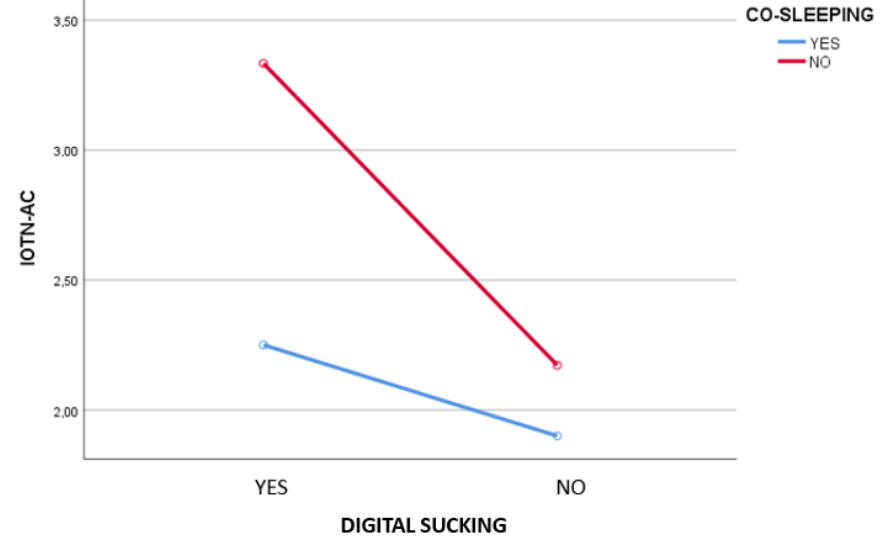
Figure 2. Two-way ANOVA for the variables of co-sleeping (yes/no) and digital sucking (yes/no) on IOTN-AC.